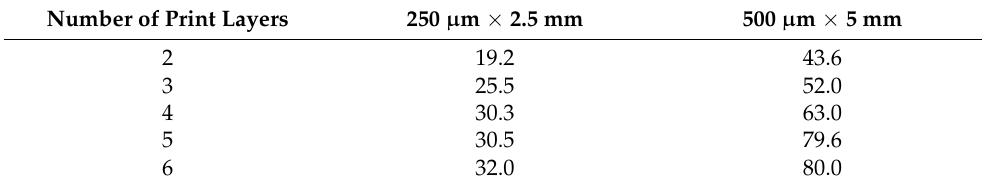
Table 2. Print thickness for each pattern with increasing number of print layers ( µ m). Number of Print